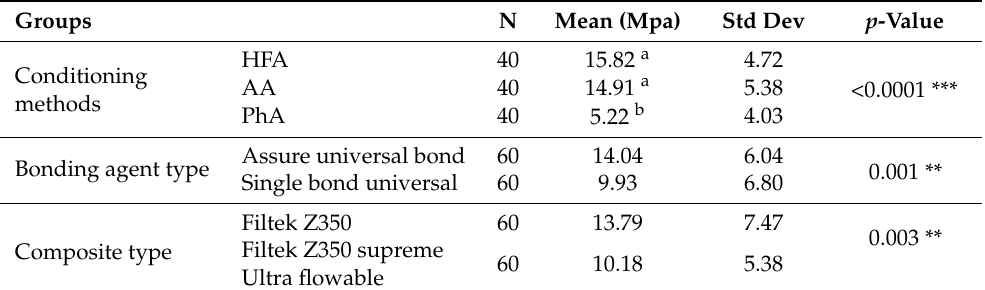
Figure 4. AFM representative images for the surface roughness of the ceramic surfaces treated with different conditioning methods; control, PhA etching group; HFA etching group, AA group. Table 2. Comparison of SBS between the groups according to the three different factors assessed: conditioning methods, bonding agents and composite